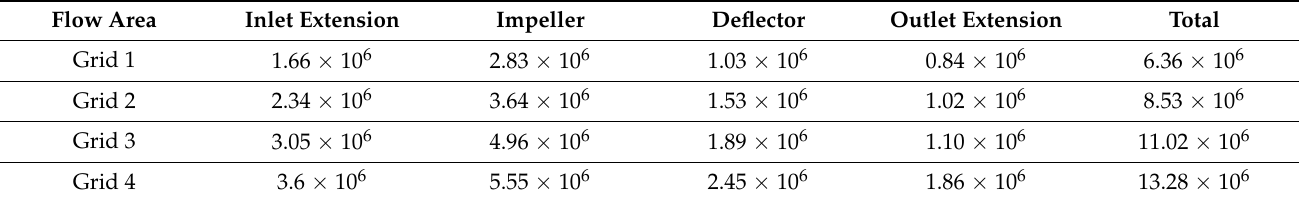
Table 2. Grid quantity